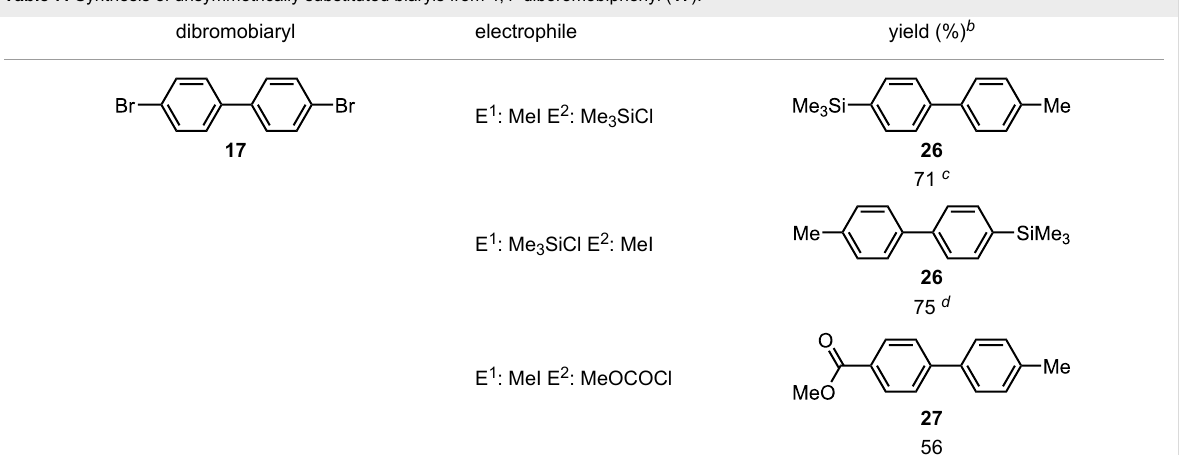
Table 7: Synthesis of unsymmetrically substituted biaryls from 4,4′-diboromobiphenyl ( 17 ).